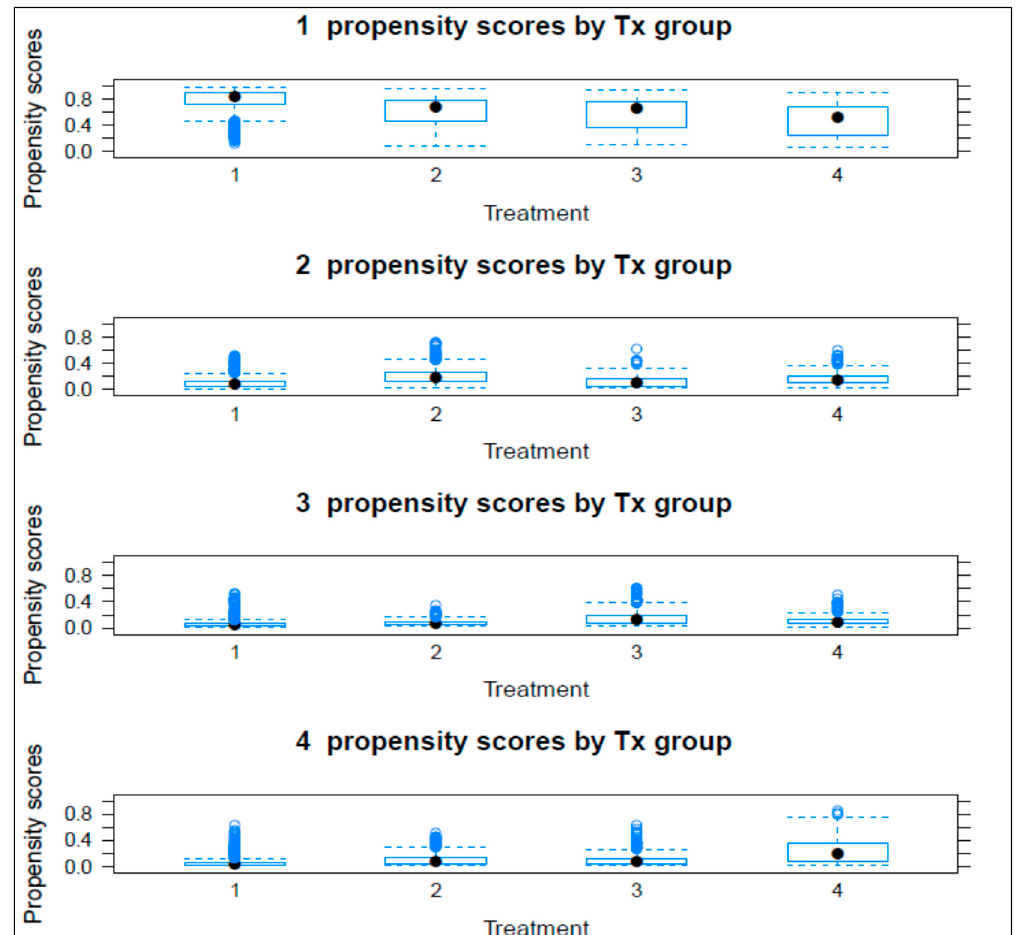
Figure A1. Overlap plots. Note: Figure A1 presents the overlap of propensity scores of each treatment group with other treatment groups. 1, 2, 3, and 4 represent non-innovators, product innovators, process innovators and product-and-process innovators, respectively.